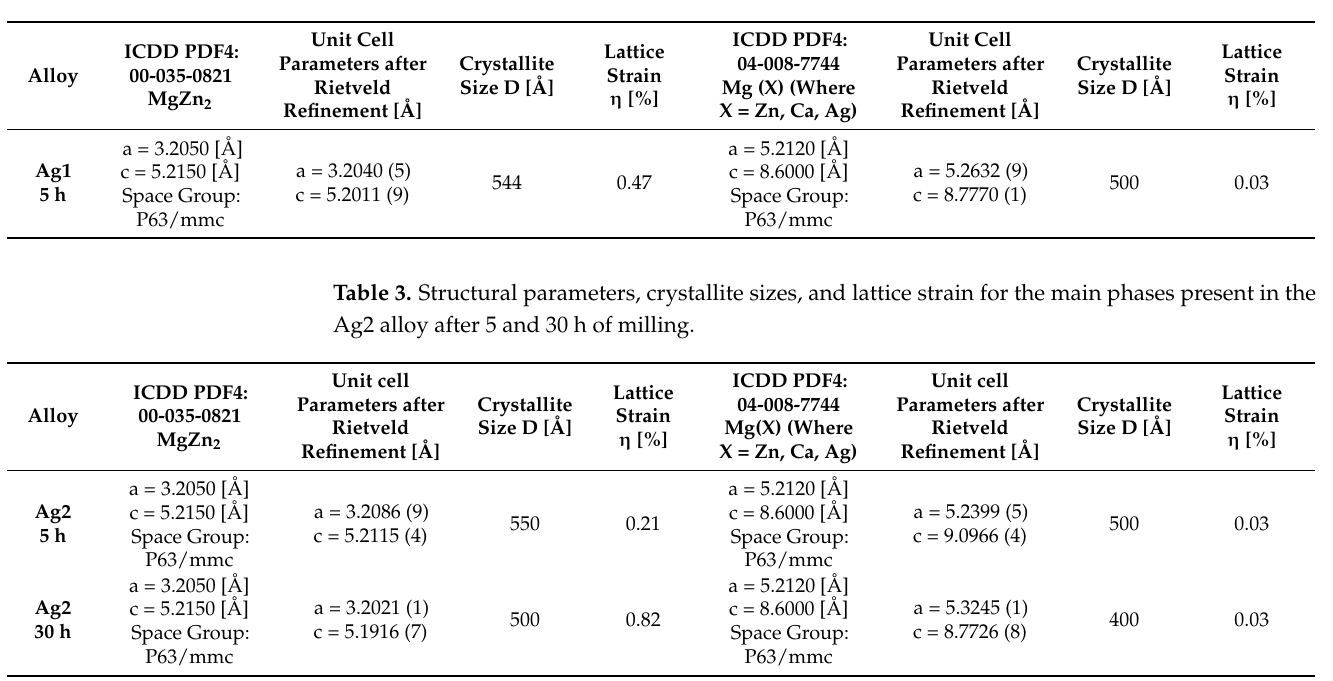
Table 2. Structural parameters, crystallite sizes, and lattice strain for the main phases present in the Ag1 alloy after 5 h of milling.